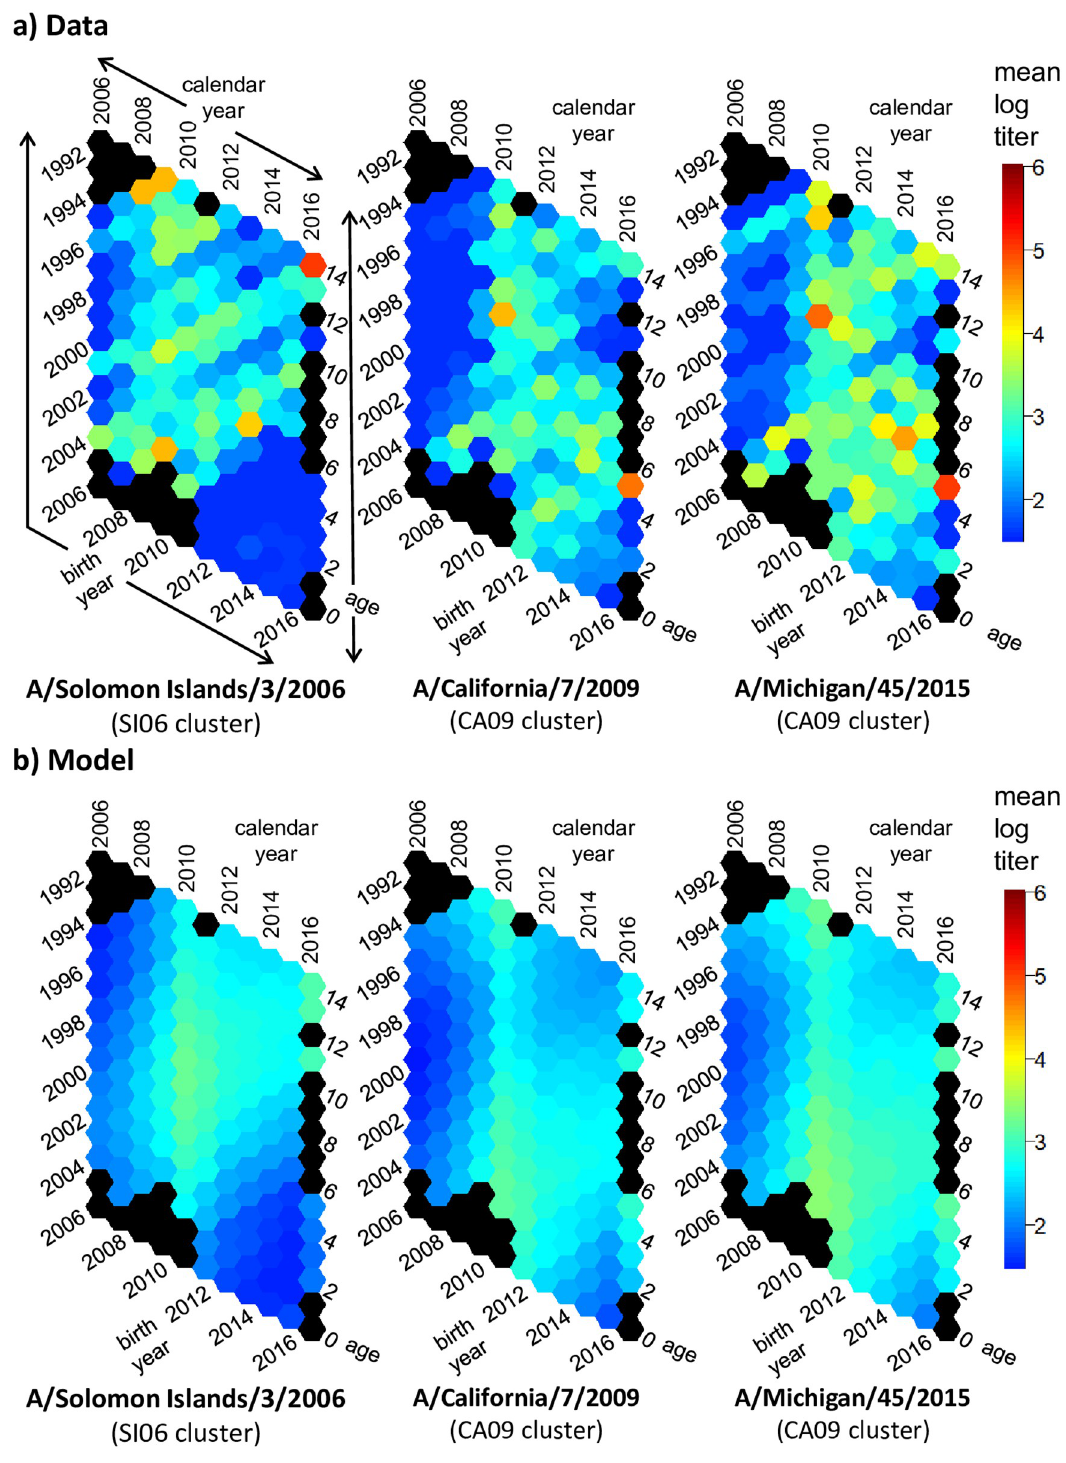
Fig 4. H1N1 hexamaps for HAI titers. a) Hexamaps visualizing H1N1 HAI mean log titers as a function of age, calendar year, and birth year in the data. b) Corresponding hexamaps for the mean log titers predicted by the H1N1 specific model with separate time effects for seasonal and pandemic strains. Black hexagons represent points with no participants.